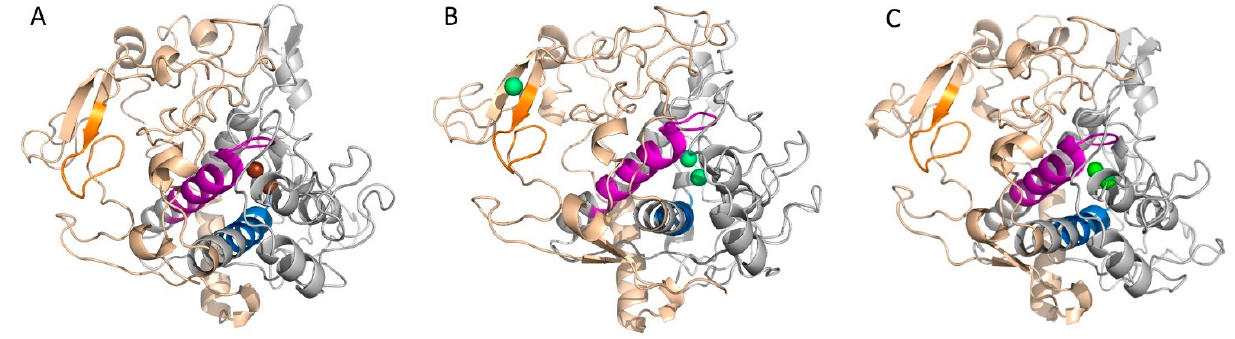
Figure 3. Three-dimensional structures of tyrosinases: ( A ) TYR, ( B ) TYRP1, ( C ) TYRP2. Grey, tyrosinase domain; magenta, CuA binding pattern; blue, CuB binding pattern; orange, EFG pattern; brown, copper atoms; green, zinc atoms.